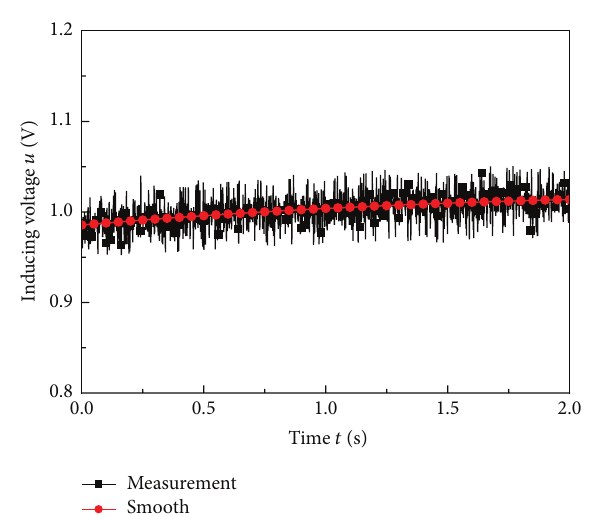
Figure 16: Inducing voltage of linear power generator with AC-DC